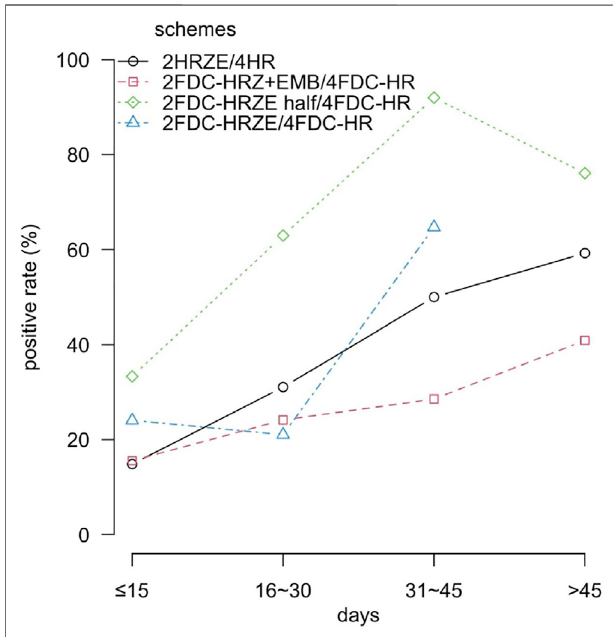
FIGURE 1 | Positive rate versus different prescription regimens and duration of medications.